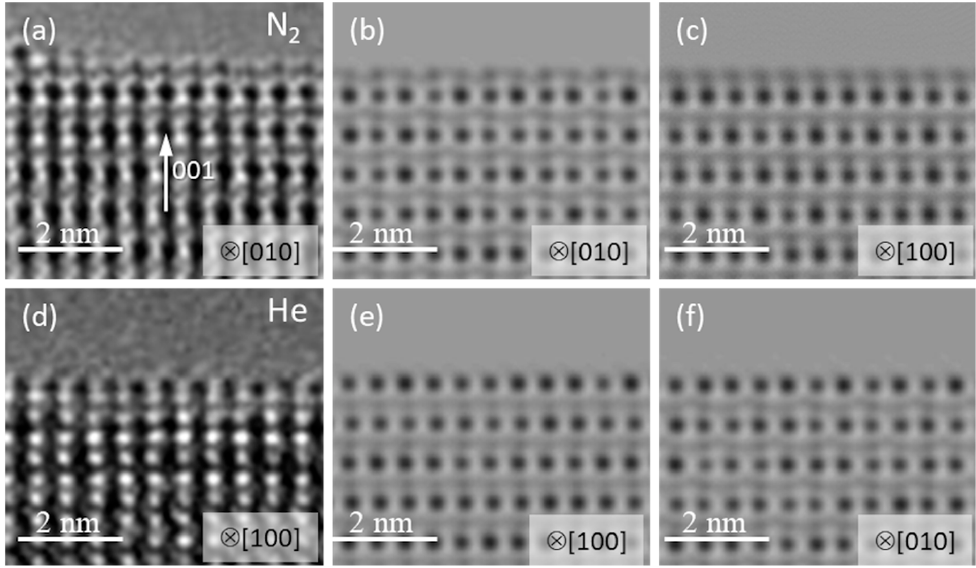
Figure 6. Experimental HRTEM images of PCMO (x = 0.33) collected in N 2 ( a ) and in He ( d ) at p = 50 ubar; ( b , c , e , f ) corresponding calculated images along [100] and [010] directions. Both A- and B-cation stable terminations are visible in N 2 , whereas only the A-cation termination of facets is visible in He.